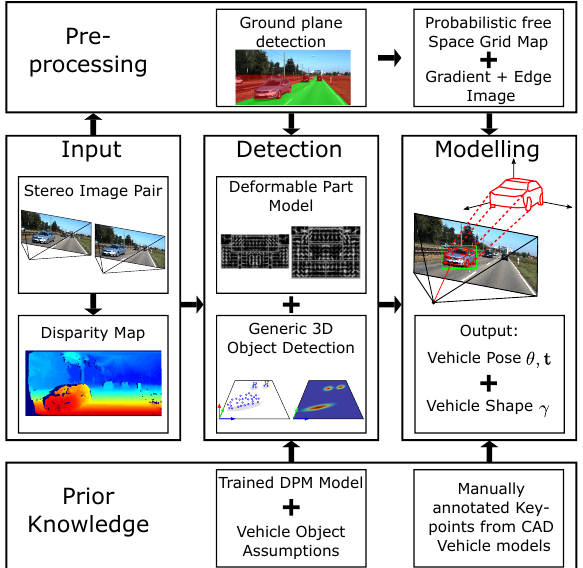
Figure 1. Overview of our